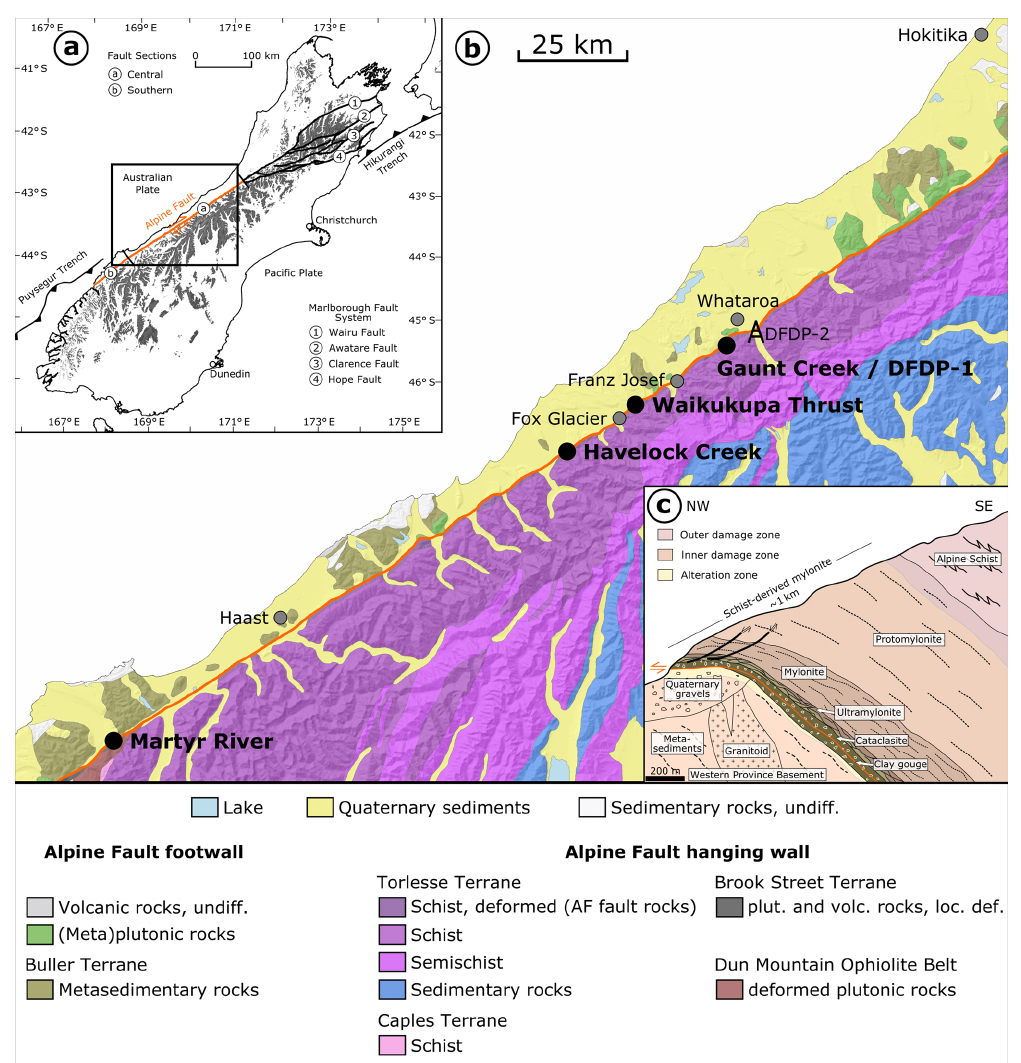
Figure 2. (a) Plate tectonic setting of New Zealand’s South Island with the Alpine Fault’s onshore segment being highlighted in orange. Position of (b) is indicated by black box. (b) Simplified geological map of the study area. Alpine Fault trace shown in orange. Locations of investigated outcrops: Martyr River, 43 ◦ 7 (cid:48) 47 (cid:48)(cid:48) S 168 ◦ 33 (cid:48) 40 (cid:48)(cid:48) E; Havelock Creek, 43 ◦ 32 (cid:48) 15 (cid:48)(cid:48) S 169 ◦ 52 (cid:48) 15 (cid:48)(cid:48) E; Waikukupa Thrust, 43 ◦ 26 (cid:48) 22 (cid:48)(cid:48) S 170 ◦ 4 (cid:48) 8 (cid:48)(cid:48) E; Gaunt Creek, 43 ◦ 18 (cid:48) 58 (cid:48)(cid:48) S 170 ◦ 19 (cid:48) 20 (cid:48)(cid:48) E. Map is based on the geological map of New Zealand’s South Island (Edbrooke et al., 2015) and the digital elevation model of Columbus et al. (2011). (c) Typical shallow-depth sequence of Alpine Fault rocks. The figure was modified from Norris and Cooper (2007). Extents of alteration zone were derived from Sutherland et al. (2012) and extents of inner and outer damage zone from Townend et al.